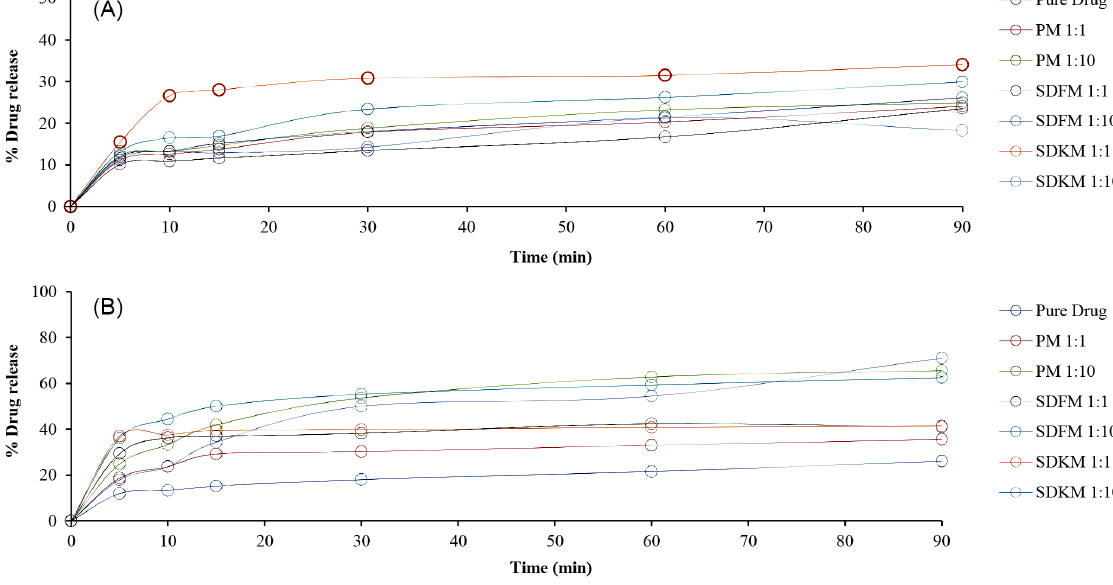
FIGURE 4 - Drug release profiles of pure AMH, physical mixture and solid dispersions obtained from fusion and kneading methods using water as dissolution medium at 37 ºC ± 0.5 ºC and carrier PEG 4000 (A) and carrier PEG 6000 (B).